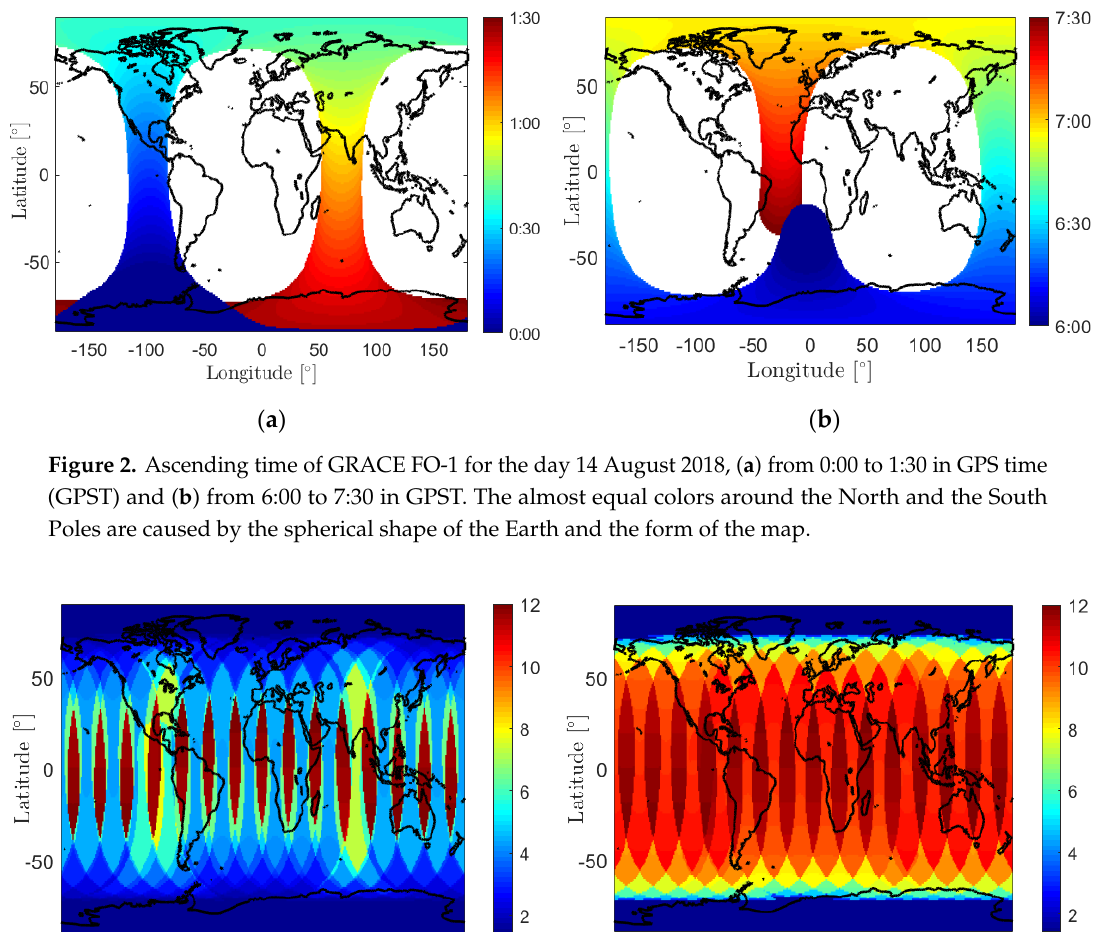
Figure 2. Ascending time of GRACE FO-1 for the day 14 August 2018, ( a ) from 0:00 to 1:30 in GPS time (GPST) and ( b ) from 6:00 to 7:30 in GPST. The almost equal colors around the North and the South Poles are caused by the spherical shape of the Earth and the form of the map.